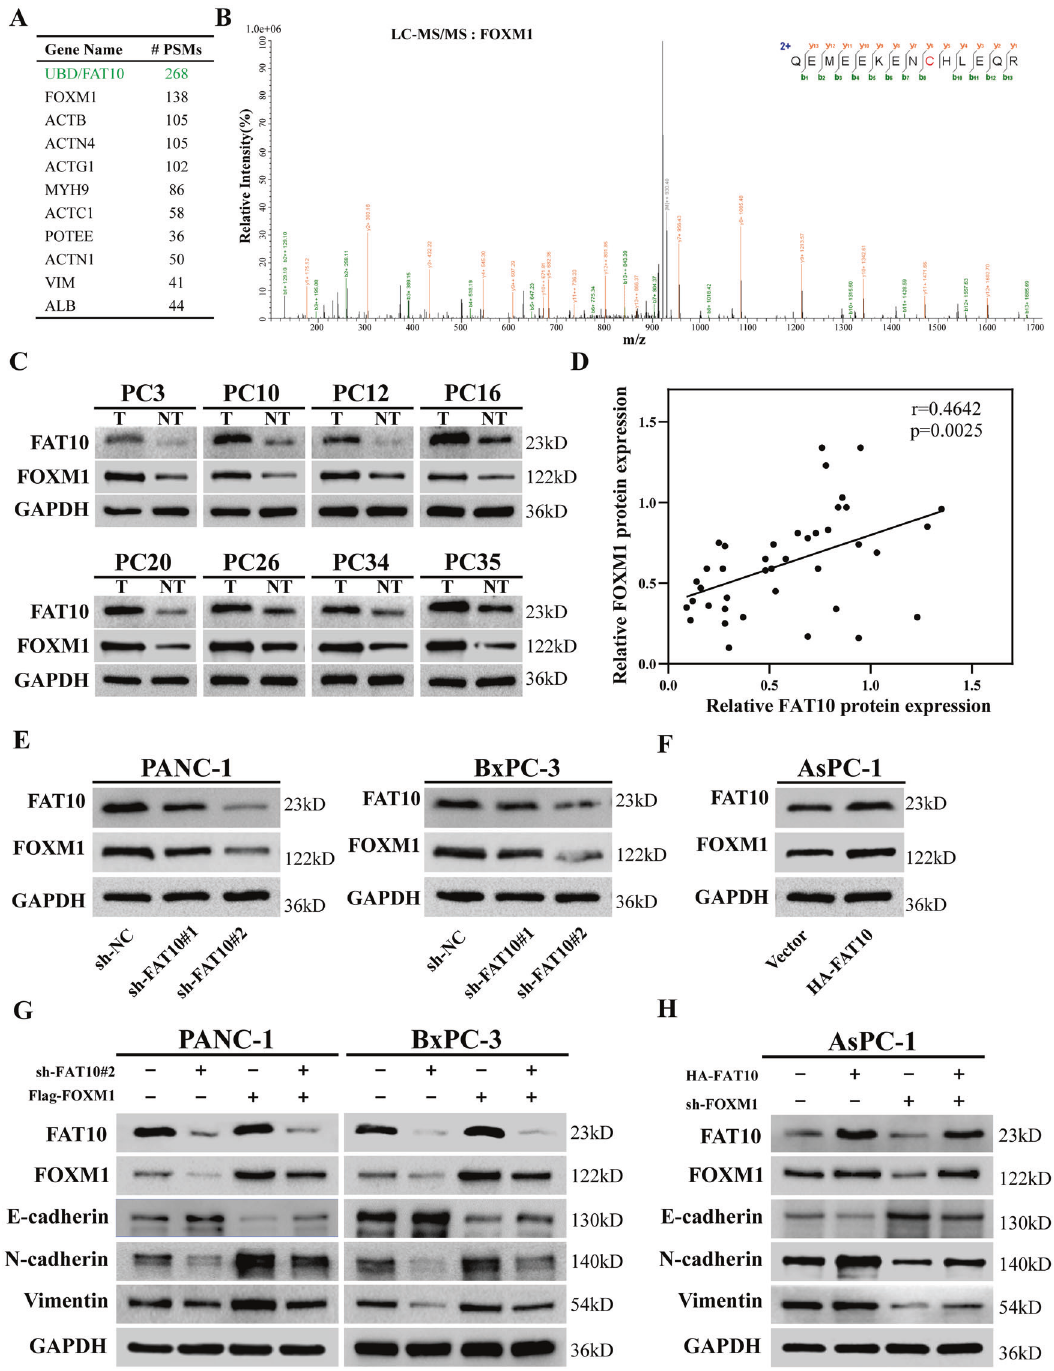
Fig. 5 FAT10 regulates EMT through FOXM1. A Top 10 proteins co-precipitated with FAT10 analyzed by LC-MS/MS. #PSMs, peptide spectrum matches. B Mass spectrum showing unique peptides of FOXM1 identi fi ed by 2D-LC-MS/MS from the protein lysates prepared from PANC-1 cells following immunoprecipitation with anti-FAT10. C Representative western blot analysis of FAT10 and FOXM1 protein expression in PC and paired paracancerous tissues (T, tumor; NT, non-tumor tissue). D Scatter plots showing a positive correlation between FAT10 and FOXM1 protein expression levels in 40 PC samples ( n = 40, r = 0.4642, p = 0.0025, Pearson test). E , F Western blot analyses were used to detect FAT10 and FOXM1 protein expression in cells stably transfected with the shFAT10 or HA-FAT10 plasmid. G Western blot analysis con fi rming FAT10 silencing and FOXM1 restoration and their effects on EMT-related proteins. H Western blot analysis showing the levels of FAT10 overexpression and FOXM1 inhibition and their effects on EMT-related proteins. FAT10 stabilizes the expression of FOXM1 by inhibiting the protein degradation. Co-IP assay results showed that FAT10 ubiquitination of FOXM1 in PC. knockout increased the ubiquitination levels of endogenous Next, we transfected PANC-1 and BxPC-3 cells with HA-FAT10 FOXM1, while FAT10 overexpression decreased the ubiquitination plasmids of different concentrations. Co-IP assay results showed levels of endogenous FOXM1 (Fig. 7B). These results indicate that Cell Death and Disease (2022)